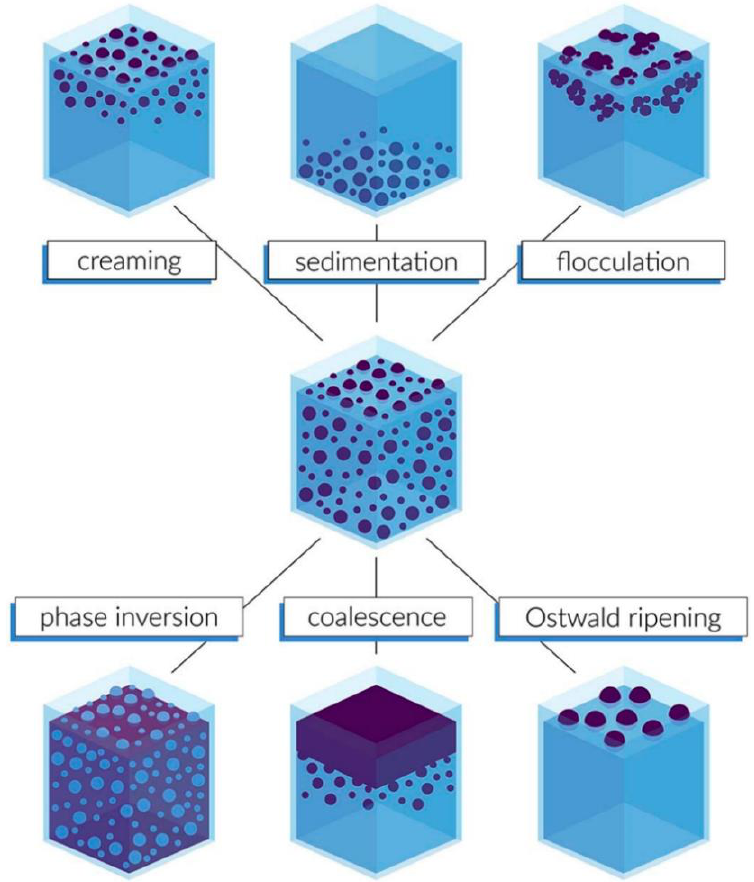
Figure 1. Instability processes in emulsions associated with microencapsulated slurries [5]. The research indicates that EPCMs-based PCSs are advantageous alternatives for cooling, cold energy storage, and cold energy transportation due to their elevated phase change temperature compared to ice and ice slurry [6]. Another superior option for cold storage and transportation is the use of PCS consisting of clathrate hydrates (also known as gas hydrates), which are crystalline structures in which small gas molecules are trapped inside hydrogen-bonded water molecule cages